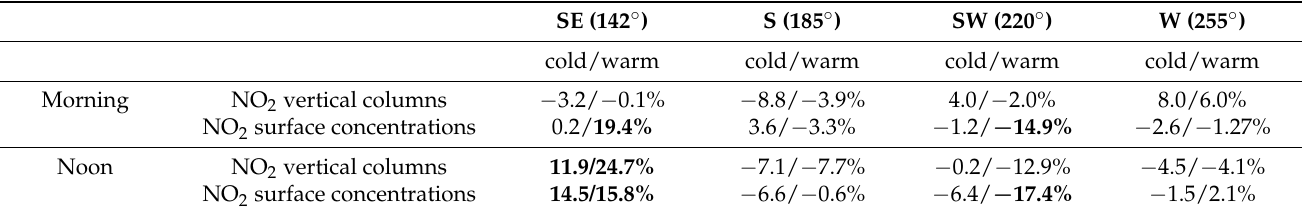
Table 1. Percentage difference of the median NO 2 VCDs and surface concentrations for each azimuth from the average concentration of all azimuths for the morning and noon hours and for the cold and warm periods. The highest differences are marked in bold. SE (142 ◦ ) S (185 ◦ ) SW (220 ◦ ) W (255 ◦ ) cold/warm cold/warm cold/warm